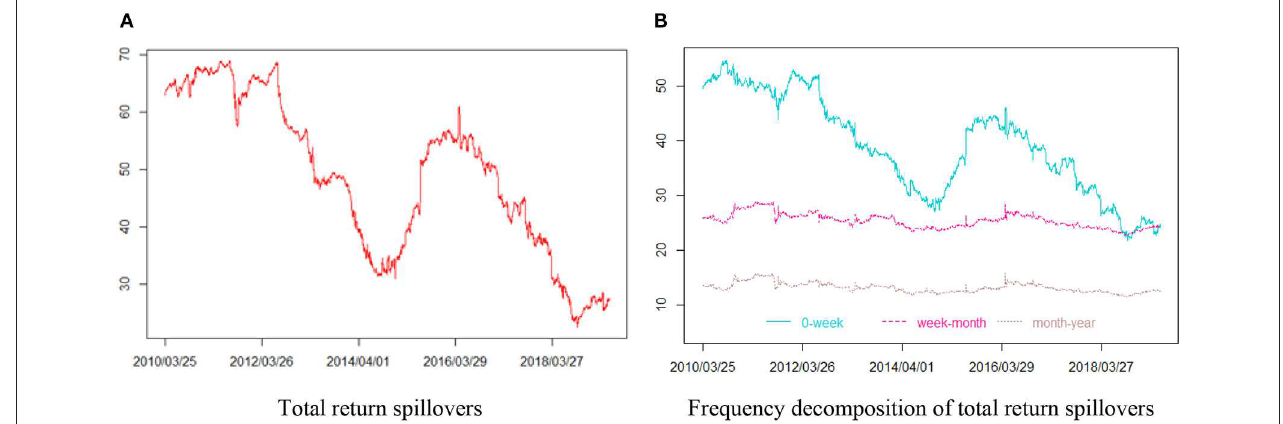
FIGURE 3 | Total return spillovers of West Texas intermediate (WTI) futures and China’s bulk commodity sectors. (A) The total return spillovers measured by Diebold and Yilmaz (2012), lag 2, window size 200. (B) The frequency decomposition measured by Baruník and Krehlík (2018), lag = = frequencies from 1 to 5 days’ period (0 week, dark turquoise). Medium term: frequencies from 5 to 20 days’ period (week–month, deep pink). Long-term: frequencies from 20 to 200 days’ period (month–year, rosy